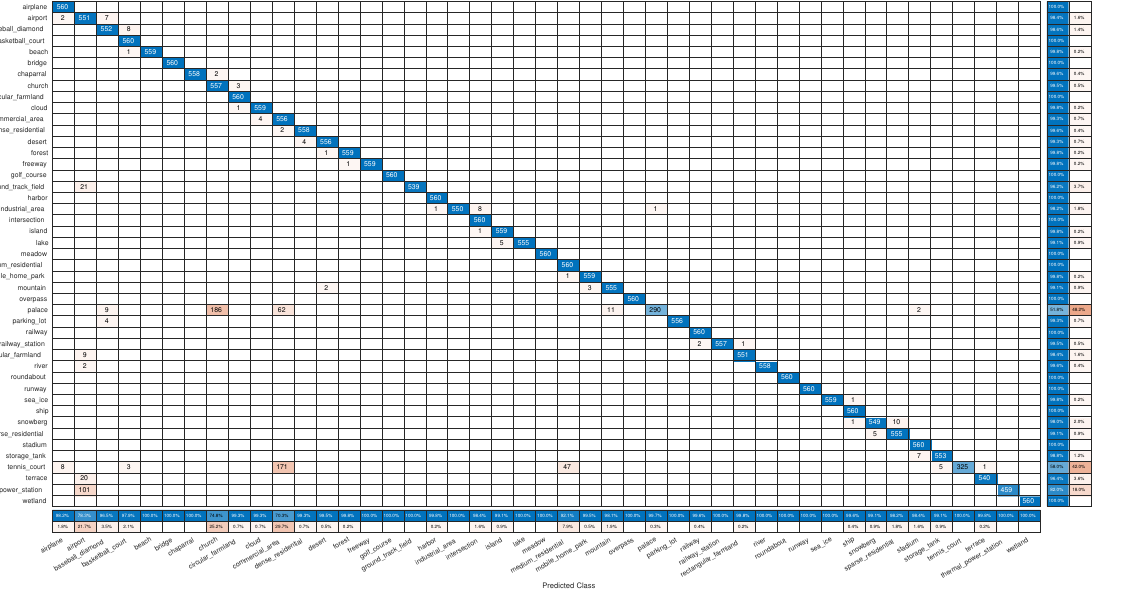
Figure 11. Confusion matrix of our proposed method on NWPU-RESISC45 Dataset by fixing the training ratio as 20%. Zoom in for a better